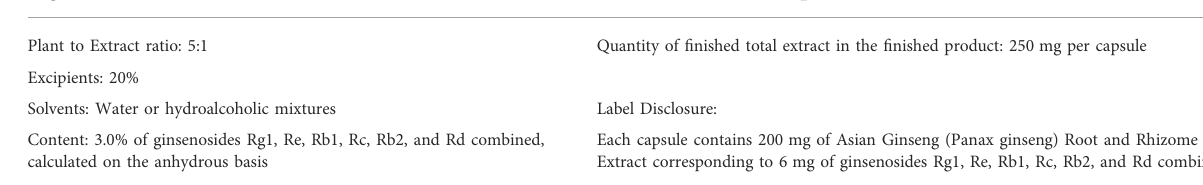
TABLE 3 Best practices for labeling of fi nished product (capsule) according to USP General Chapter < 565 > Botanical Extracts (United States Pharmacopeia (USP))